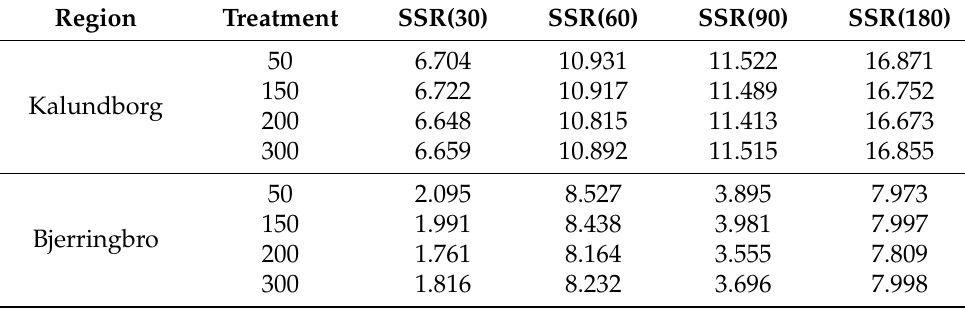
Table 4. Four depth soil sensor readings (SSR) by region and treatment.